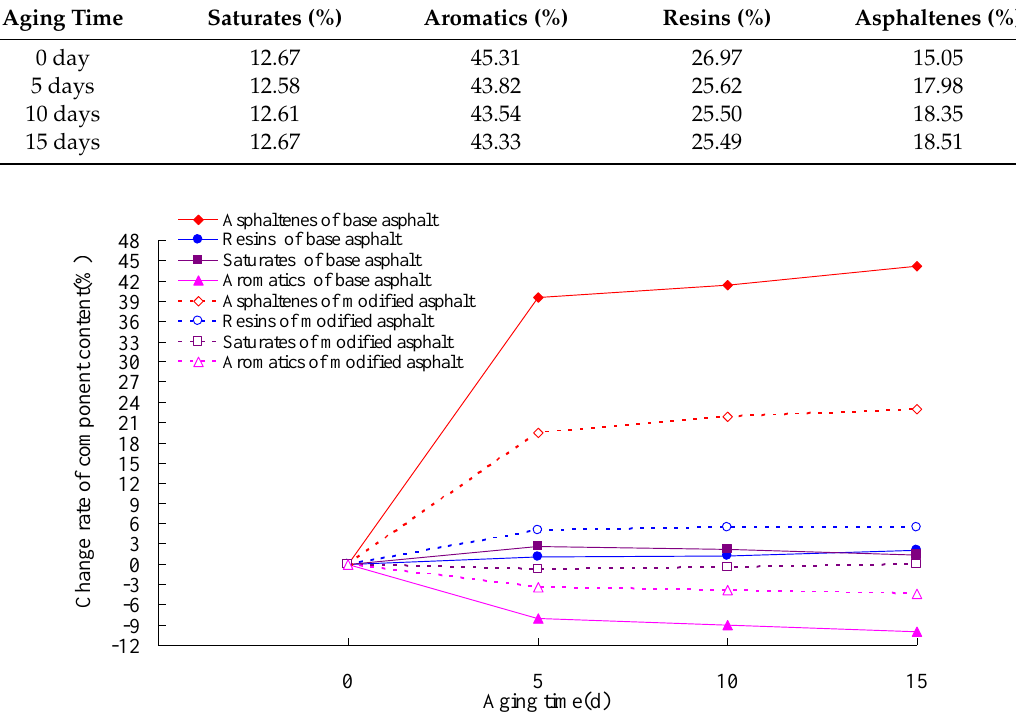
Figure 12. Change rate of component content and aging time for ZH-70 base and modified Figure 1 2. Change rate of component content and aging time for ZH-70 base and modified asphalt.